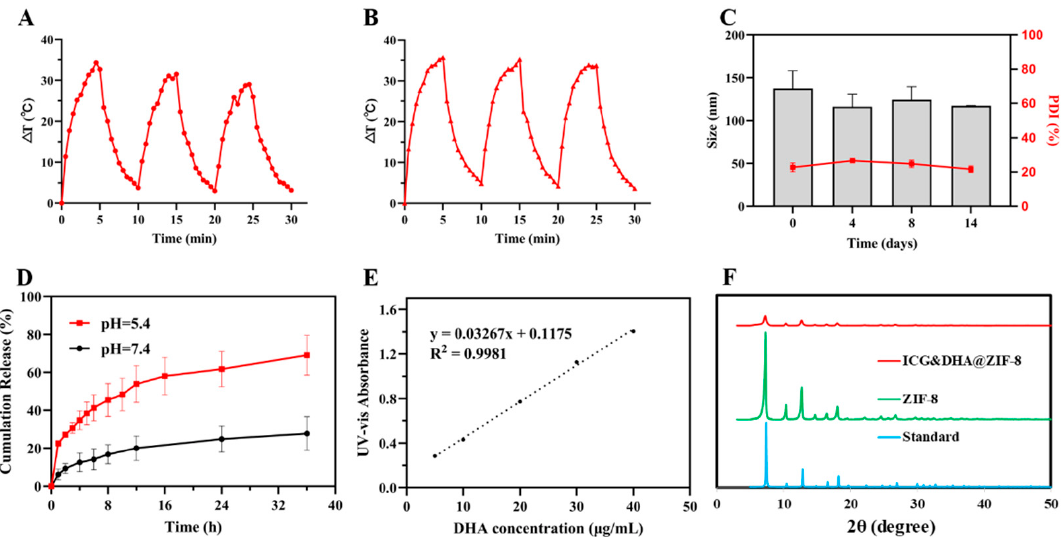
Figure 2. ( A , B ) The photothermal properties of free ICG and ICG&DHA@ZIF-8 (808 nm, 0.785 W/cm 2 ). ( C ) The size variation and PDI of the ICG&DHA@ZIF-8 in water. ( D ) Cumulative DHA release from ICG&DHA@ZIF-8 in PBS at pH 7.4 and pH 5.4. ( E ) The standard curve of DHA con-